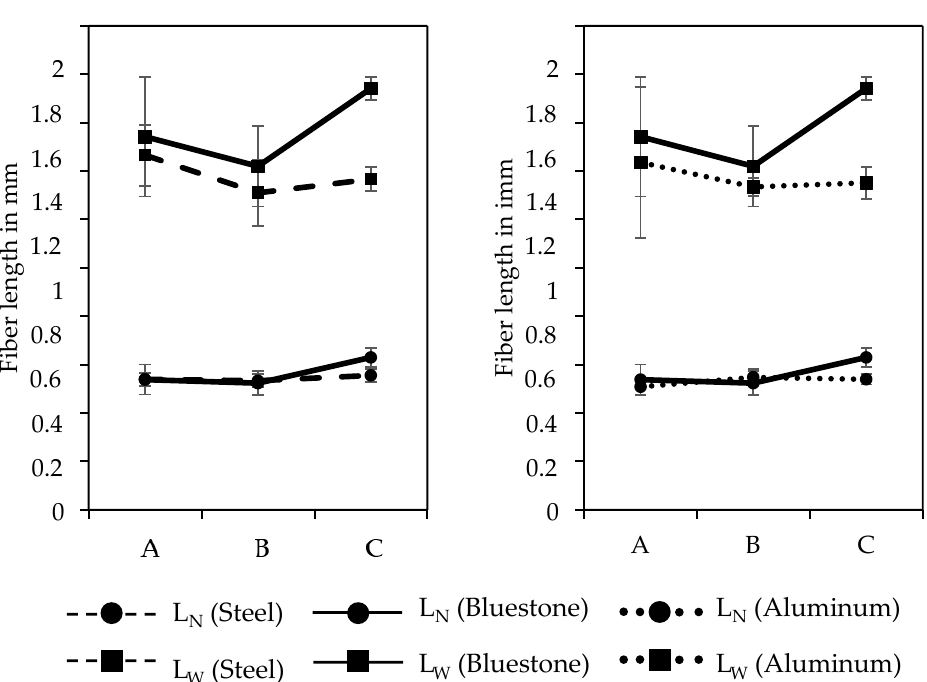
Figure A4. Fiber length (N = number average; W = weight or length average) for different tool types (for better representation in two diagrams) with 10 wt.% nominal fiber content at different specimen locations A, B, and C in accordance with Figure 7.